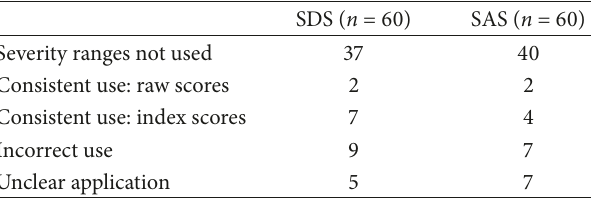
Table 4: Number of papers applying severity ranges correctly and incorrectly. SDS ( n = 60) SAS ( n = 60) Severity ranges not used 37 40 Consistent use: raw scores 2 2 Consistent use: index scores 7 4 Incorrect use 9 7 Unclear application 5